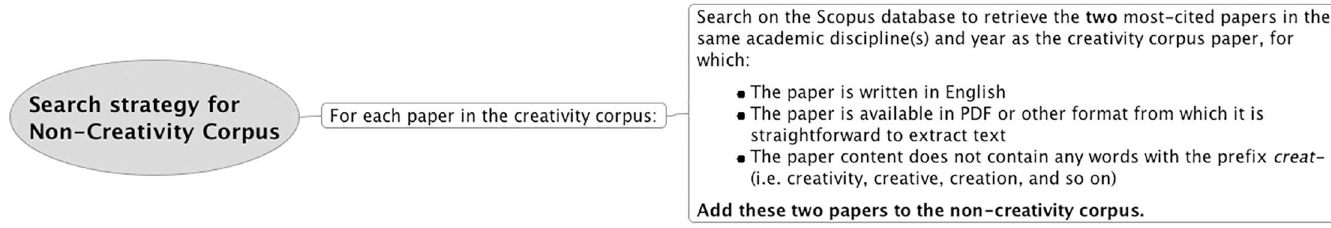
Fig 3. A flow diagram describing the search strategy used to identify papers for the non-creativity